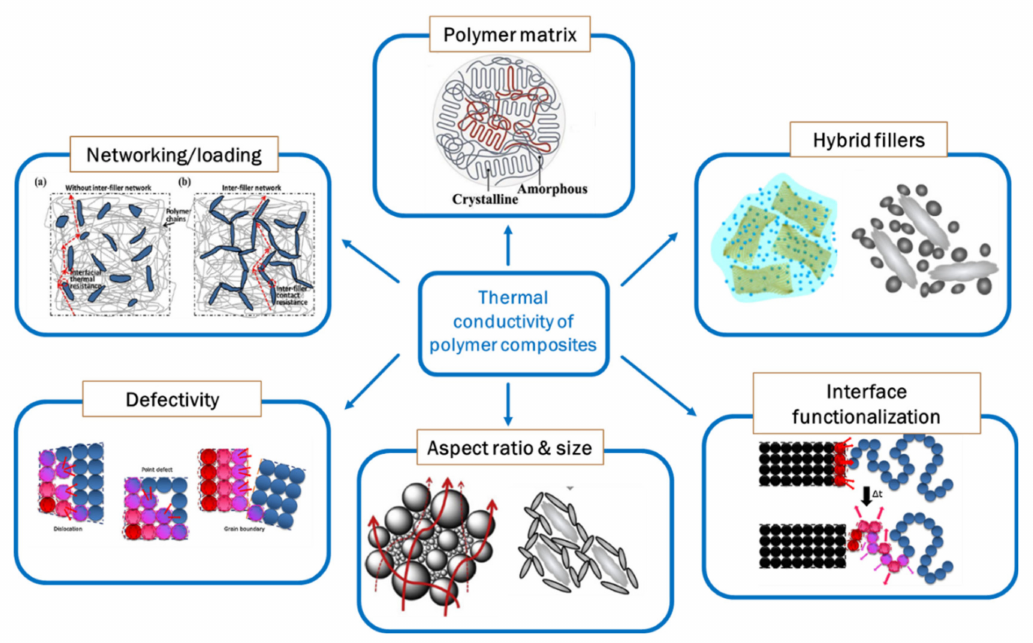
Figure 2. Main factors influencing the thermal conductivity in polymer